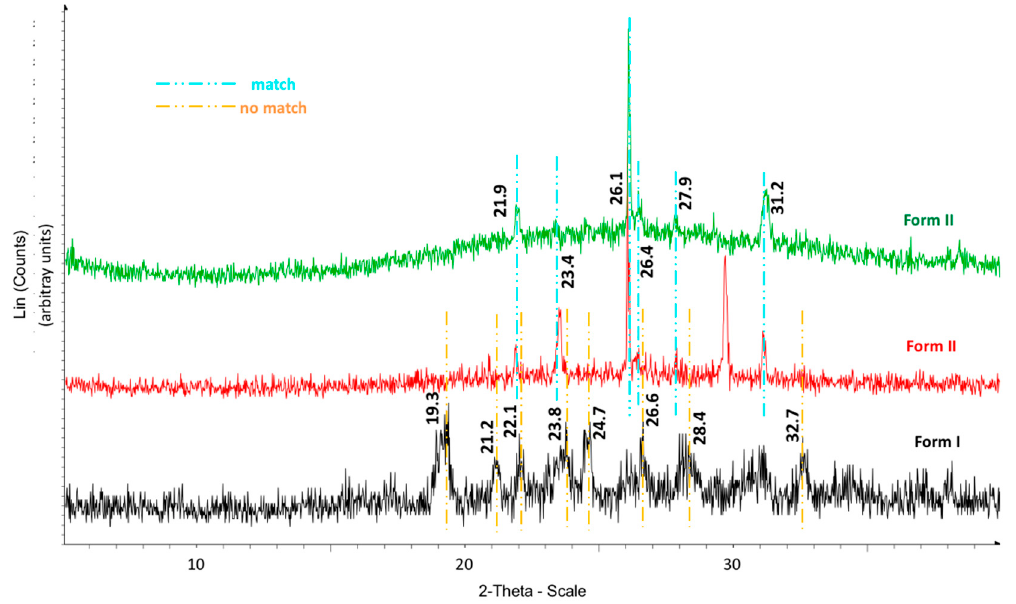
Figure 8. X-ray diffractograms of the forms of VA7J obtained after successive cycles of melting- recrystallization.